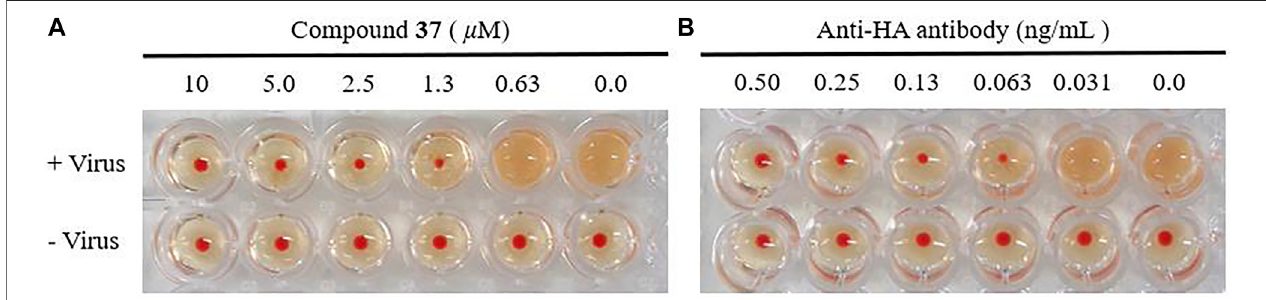
FIGURE 5 | Effect of the heptavalent compound 37 (A) and anti-HA antibody (B) on HA by HI assay. The chicken red blood cells (cRBCs) (1% v/v in saline) were incubated with in fl uenza A/WSN/33 at 2 × HA with various concentrations of 37 (two-fold serial dilution from 10 μ M) or anti-HA antibody (two-fold serial dilution from 0.50 ng/ml).